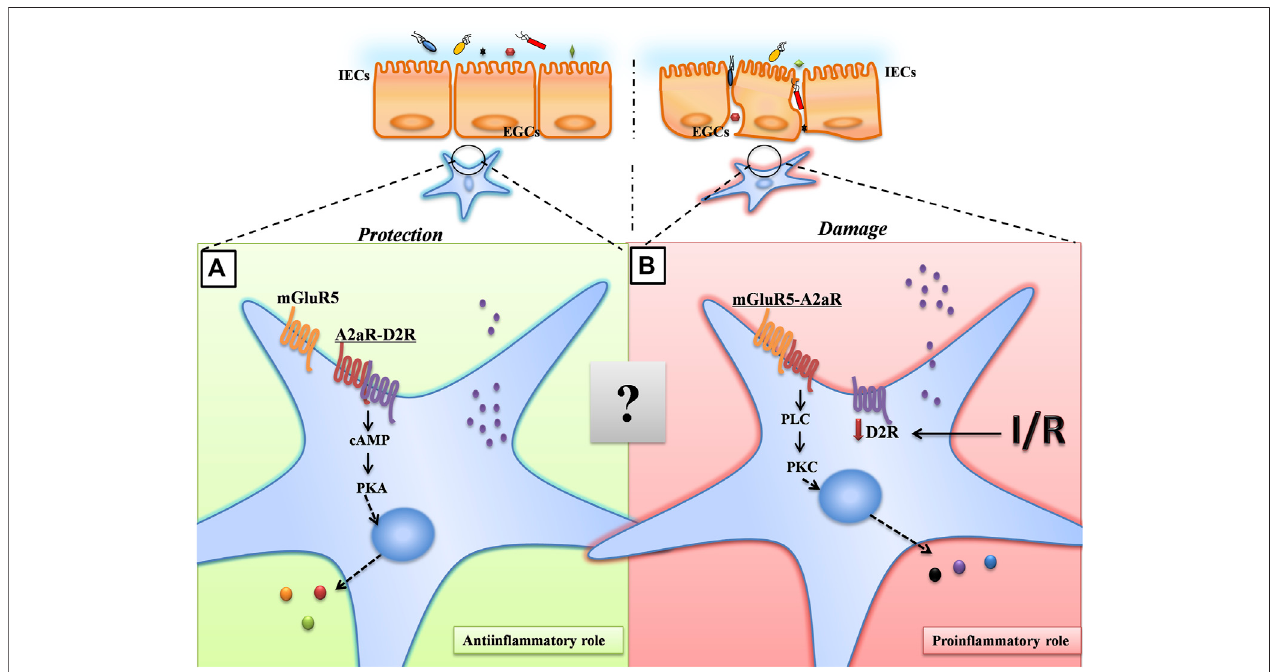
FIGURE 6 | A proposed model for A 2A R in the maintenance of intestinal barrier function. Under normoxic conditions, A 2A R combines with D2R to maintain the